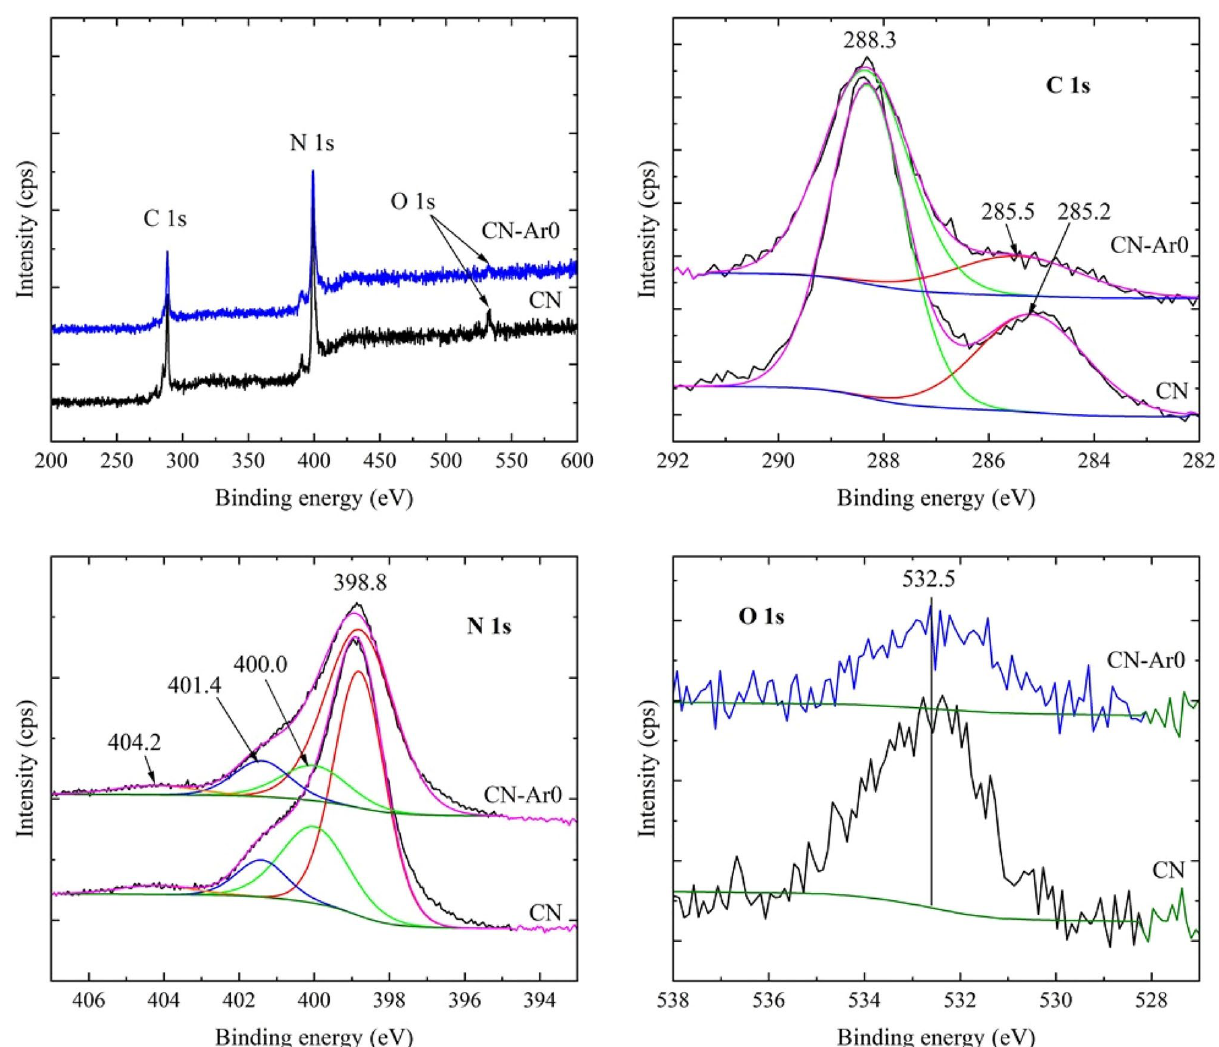
Figure 6. XPS spectra of CN and CN-Ar0